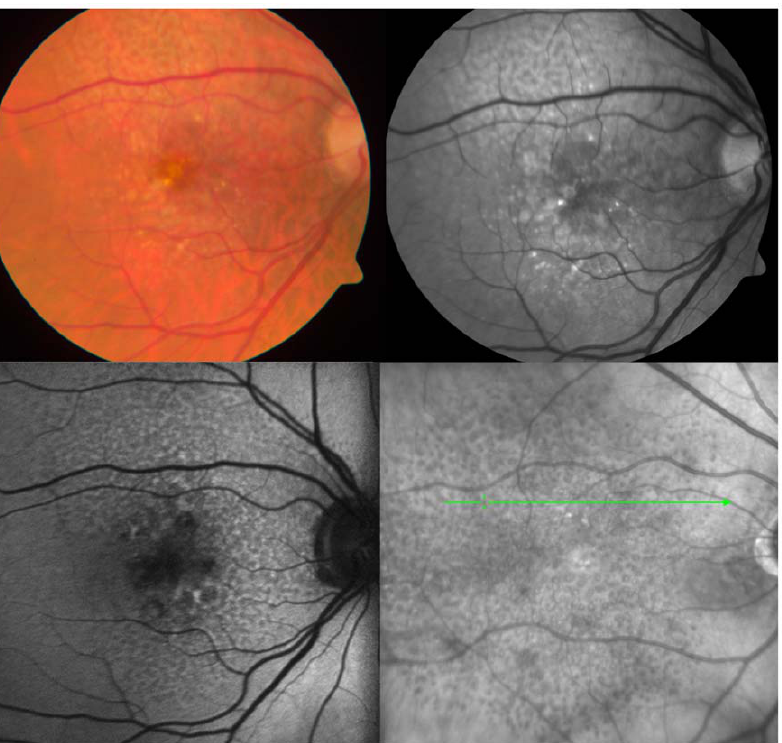
Figure 1. Imaging Characteristics of Reticular Pseudodrusen. Reticular pseudodrusen appear as faint, yellowish, interlacing networks along the arcades on color fundus images (top left) and as light interlacing networks on red-free imaging (top right). Imaging with autofluorescence (bottom left) and infrared (bottom right) improves visualization of reticular pseudodrusen as hypoautofluorescent or hyporeflectant lesions, respectively, extending along the arcades and through the fovea.